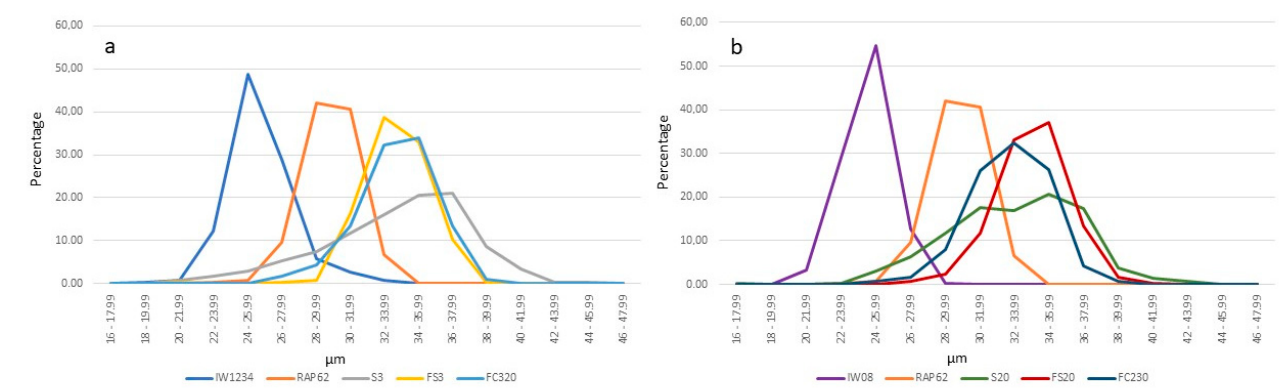
Figure 5. Distribution of pollen grain sizes (%) in parental genotypes and interspecific hybrids. ( a ) Head cabbage IW1234, rapeseed RAP62, S3F1 (head cabbage × rapeseed), FS3 F2 (S3 × self), and FS320 F2 (S3 × mixture of pollen). ( b ) Kale IW08, rapeseed RAP62, S20 F1 (kale × rapeseed), FS20 (S20 × self), and FS230F2 (S20 × mixture of pollen).